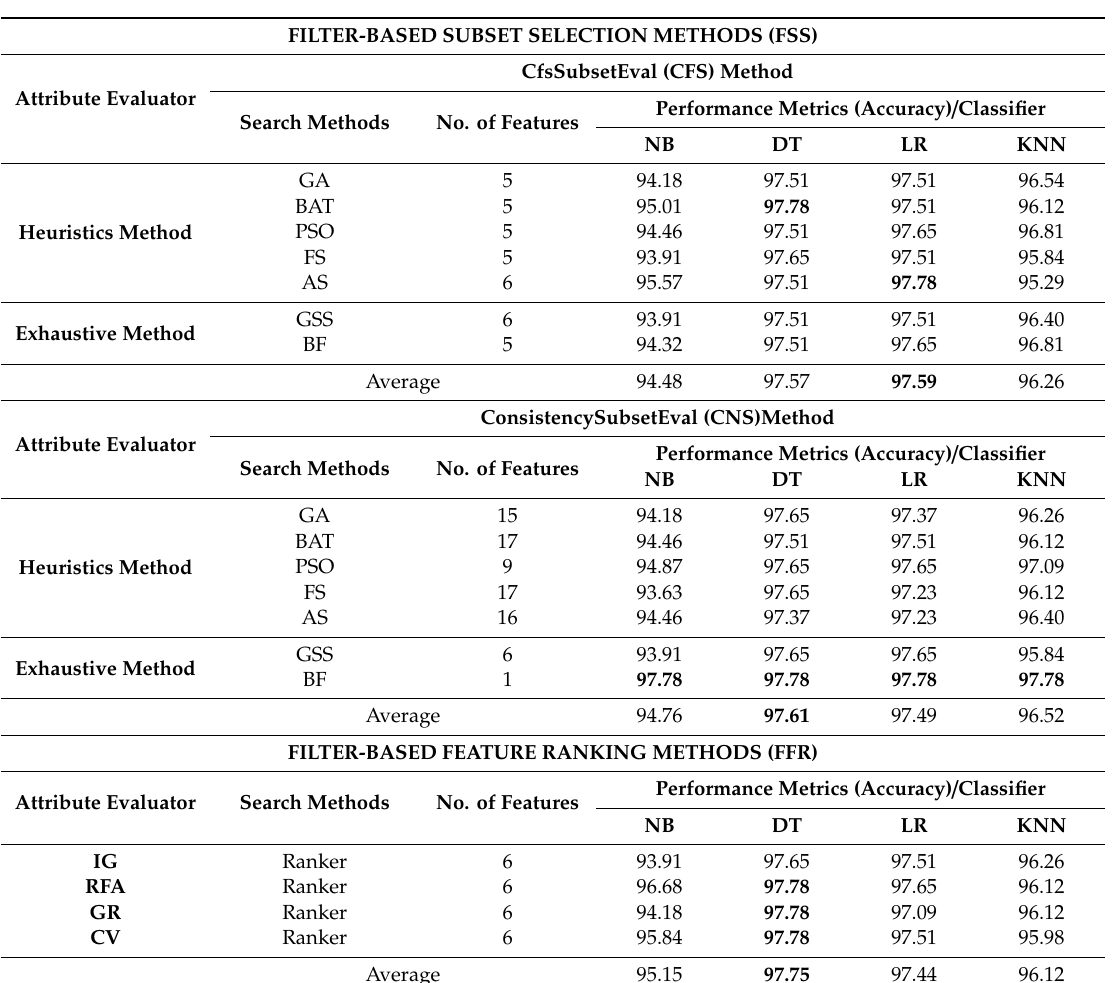
Table 14. Performance Accuracy Values of FS-based Prediction Models on PC2